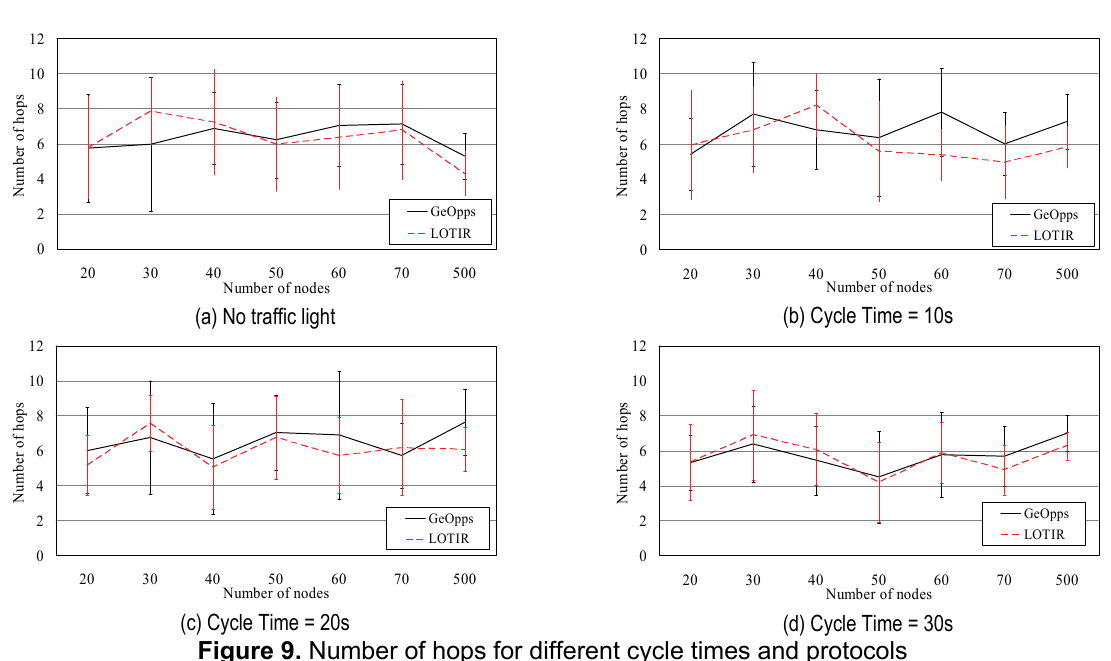
Figure 8. Packet delivery ratio for different cycle times and protocols